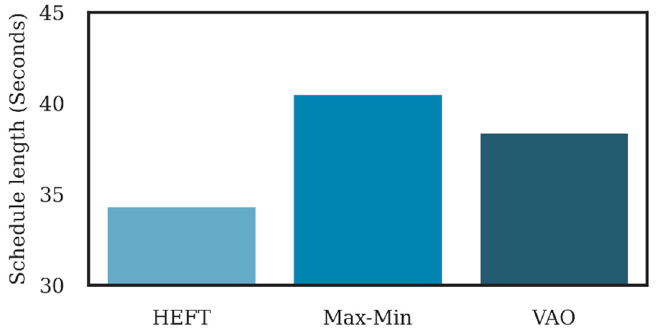
Figure 5. Initial schedule length without reallocation for a depth 4 and width 4 DAG application.